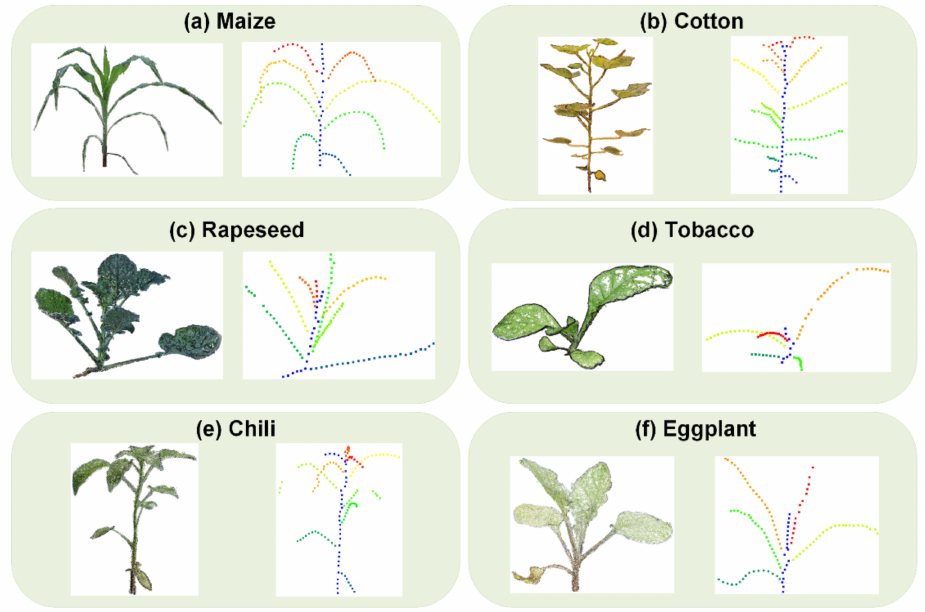
Figure 6. Visualization of reconstructed point clouds and stalk skeletonization results regarding 6 species of